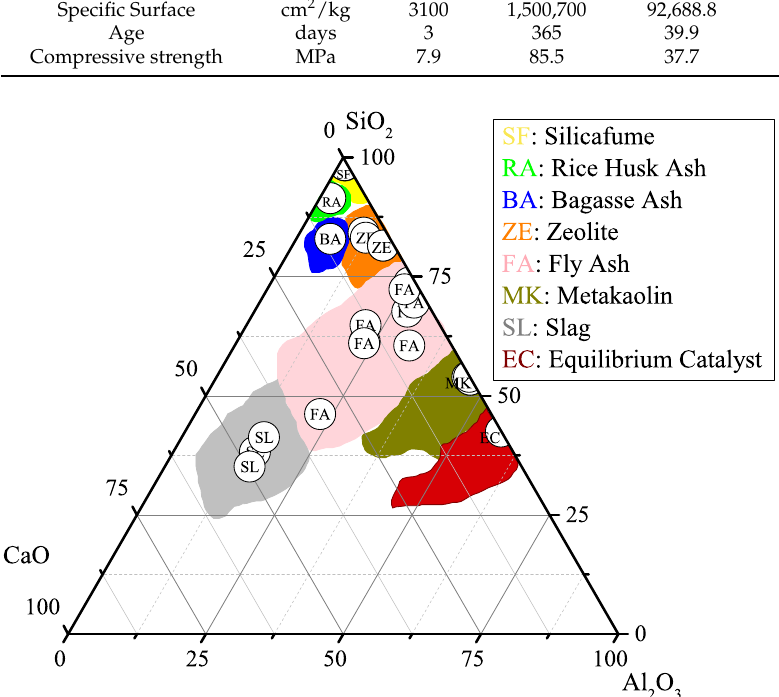
Figure 2. Chemical composition of various SCMs in the